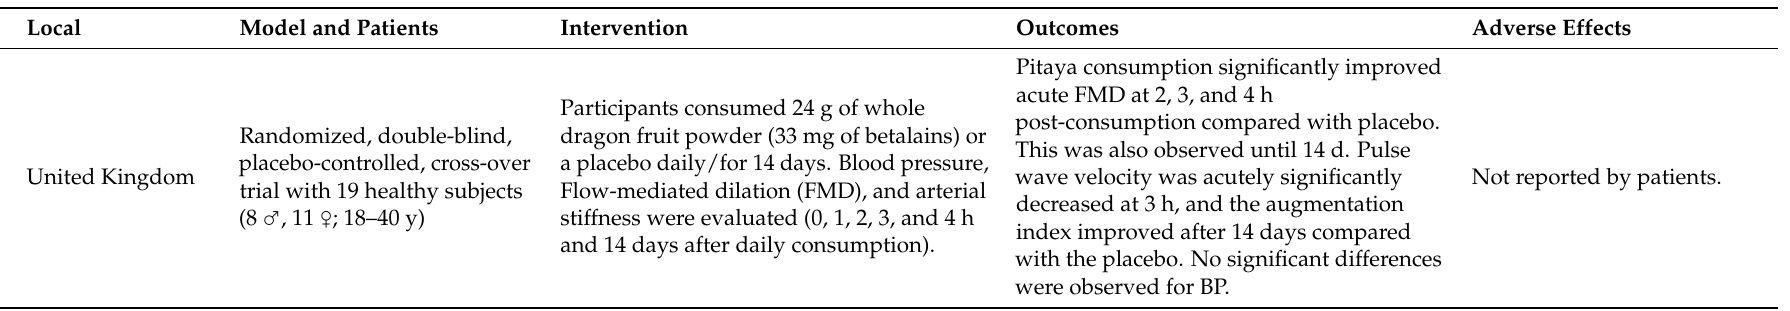
Table 5. Effects of the genus Hylocereus in human